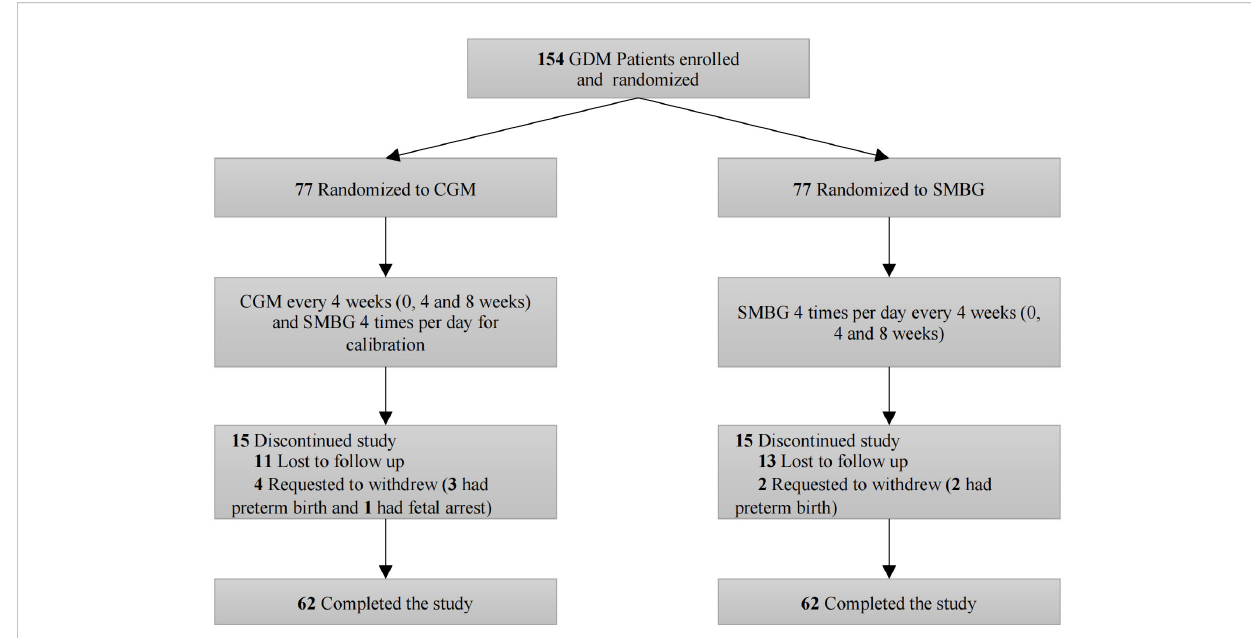
FIGURE 1 Study design. GDM, gestational diabetes mellitus; CGM, continuous glucose monitoring; SMBG, self-monitored blood